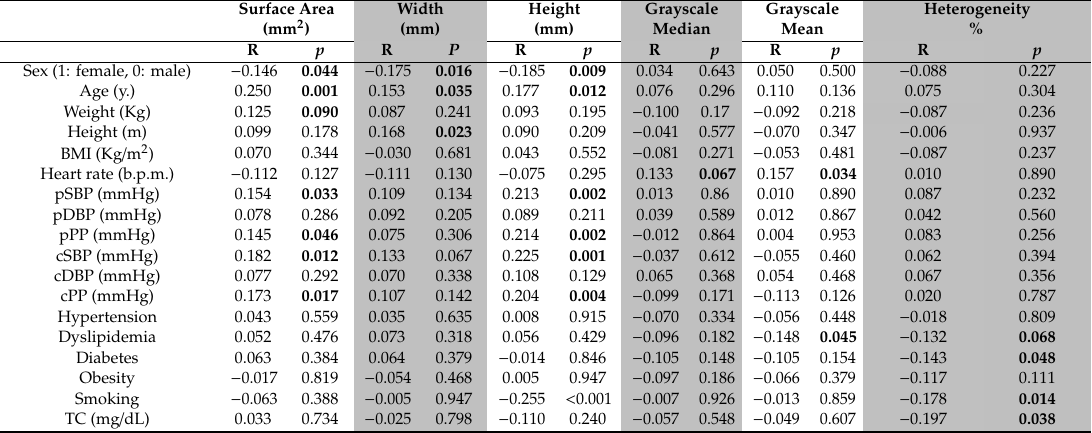
Table 3. Association of plaques’ geometry and composition with subjects’ demographic, anthropometric, hemodynamic and cardiovascular risk characteristics ( n =